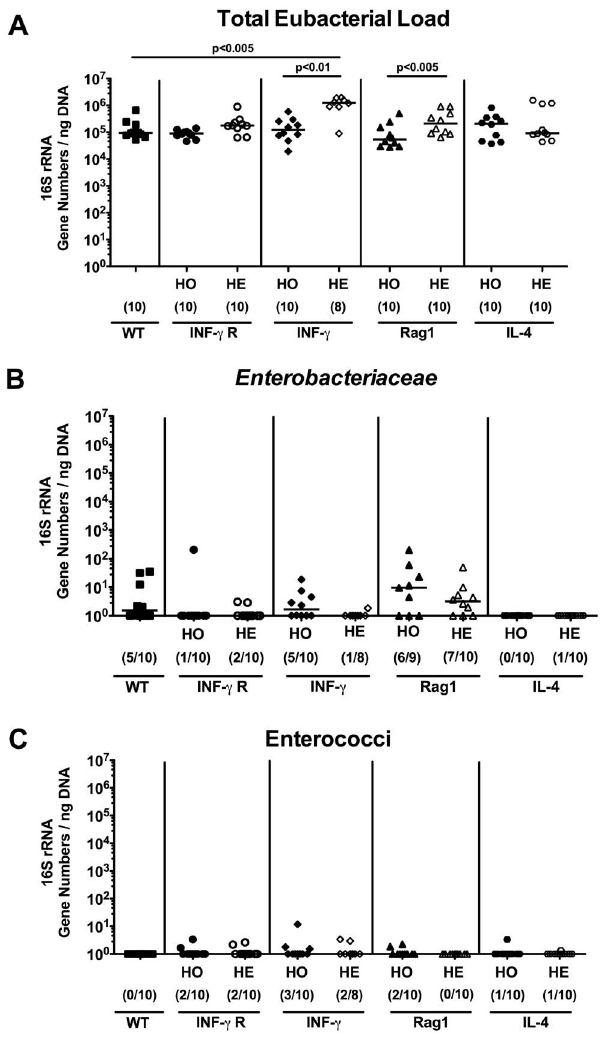
Figure 1. Commensal intestinal microbiota composition (total eubacterial load, Enterobacteriaceae and enterococci) of mice kept under SPF conditions. After twelve weeks of housing under SPF conditions, 16S rRNA of main intestinal bacterial groups was quantified by qRT-PCR in fecal samples derived from homozygous (HO; filled symbols) and heterozygous (HE; open symbols) mice deficient for IFN- c Receptor (IFN- c R; circles), IFN- c (diamonds), Rag1 (triangle), or IL- 4 (hexagons). Wildtype C57BL/6 (WT, black squares) served as controls. ( A ) Individual total eubacterial loads, and quantitative abundance of ( B ) Enterobacteriaceae and ( C ) enterococci are expressed in gene numbers per ng DNA. Medians (black bars), levels of significance ( P -values) determined by the Mann-Whitney-U test and numbers of analyzed animals (in parentheses) are indicated.